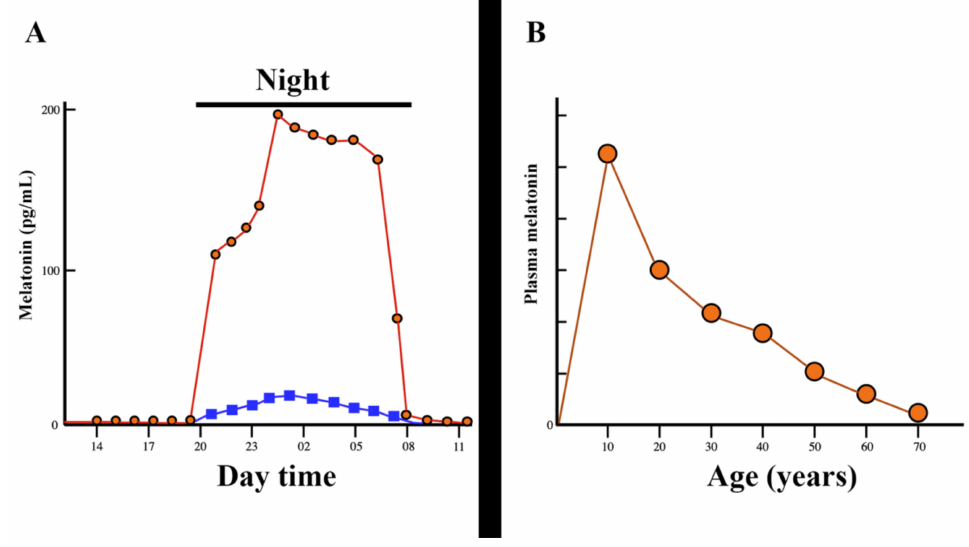
Figure 2. Evolution of melatonin secretion during the day and throughout life. ( A ): Plasma melatonin levels rise abruptly as the night begins, but this high increase comes from the pineal gland (red circles and red lines), while extra-pineal melatonin only experiences a small increase in plasma (blue squares and blue lines). When the darkness disappears, plasma levels of melatonin are virtually undetectable. However, even during high nocturnal secretion, a flash of 2000 lux sustained for one minute leads to the abolition of melatonin secretion (not shown in Figure). ( B ): The nocturnal secretion of melatonin is very low at birth, but then its pineal production increases continuously until it reaches its peak at puberty. From this age, the pineal production of melatonin undergoes a progressive decrease until it is practically undetectable in the elderly. (The red circles and red lines indicate the average amount of pineal melatonin production throughout life). Modified from reference